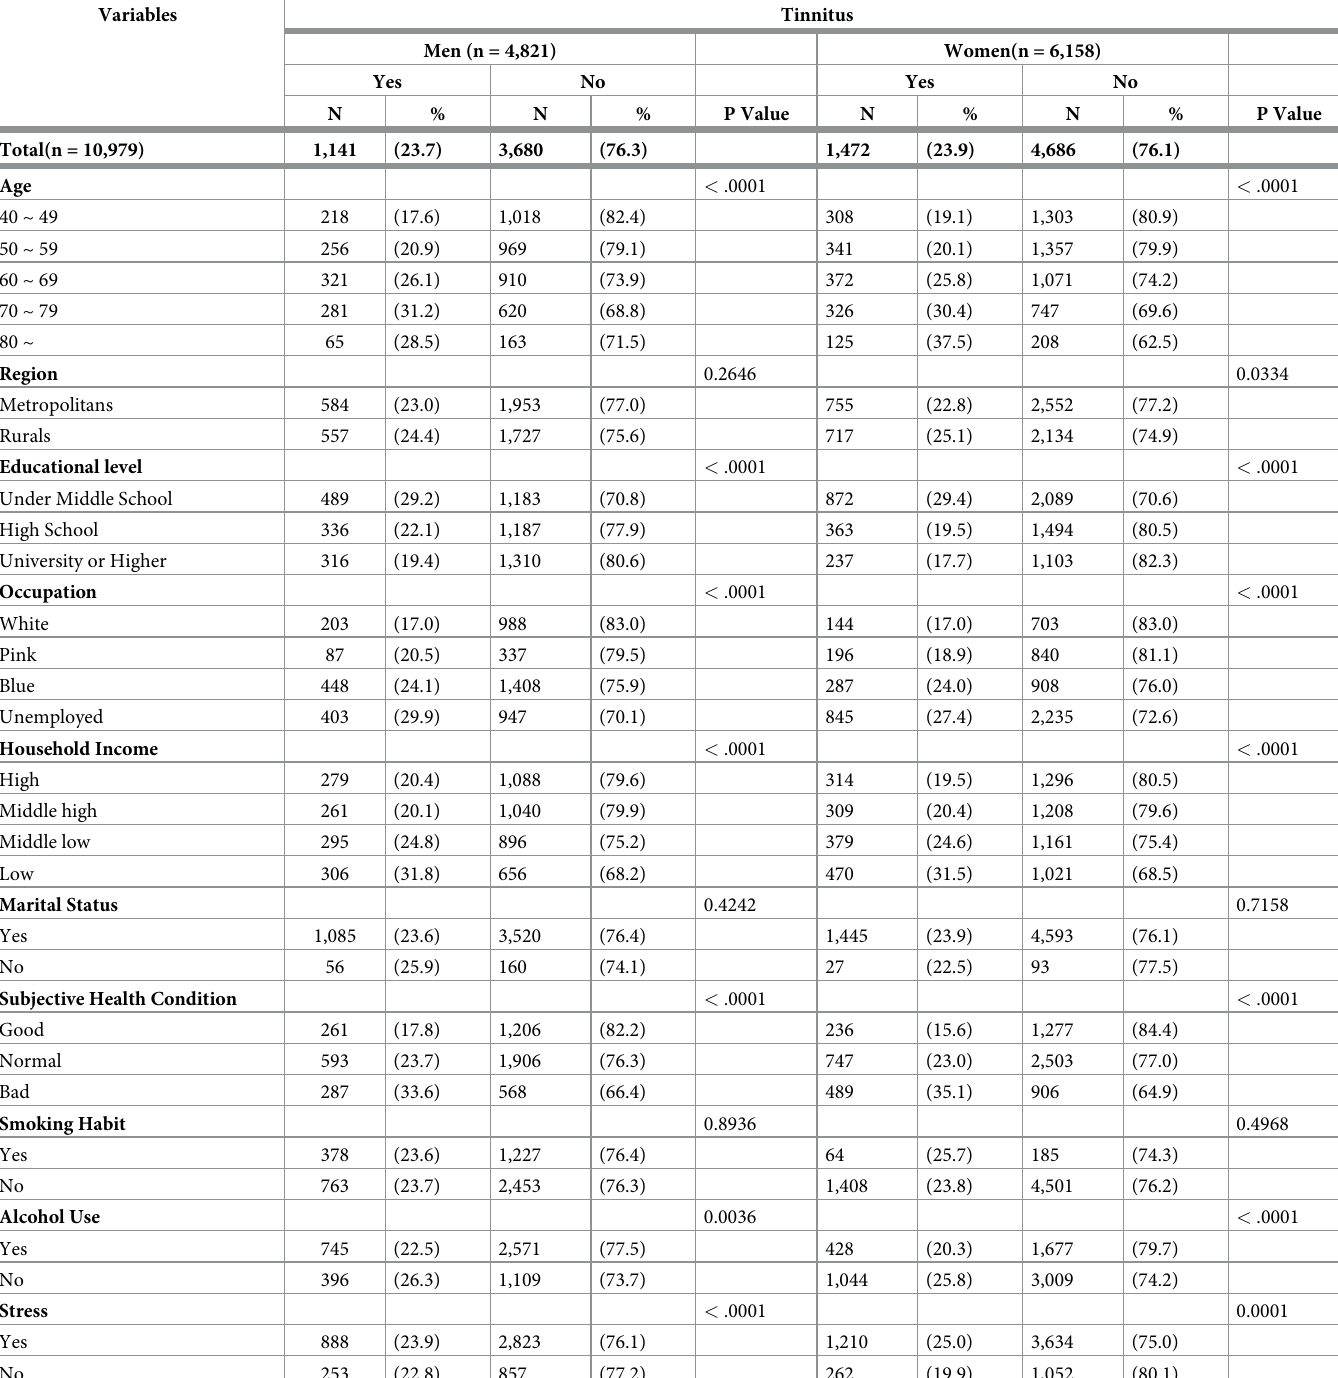
Table 2. Demographic characteristics of the study population according to